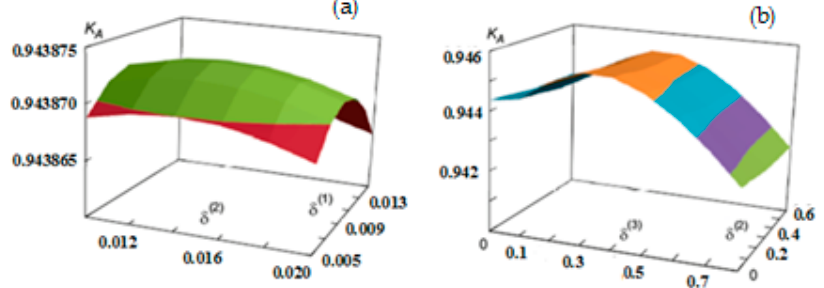
Figure 12. The dependence of the readiness coefficient K A on the relative operating tolerances for the controlled parameters: ( a ) on δ ( 1 ) and δ ( 2 ) ; ( b ) on δ ( 2 ) and δ ( 3 ) .